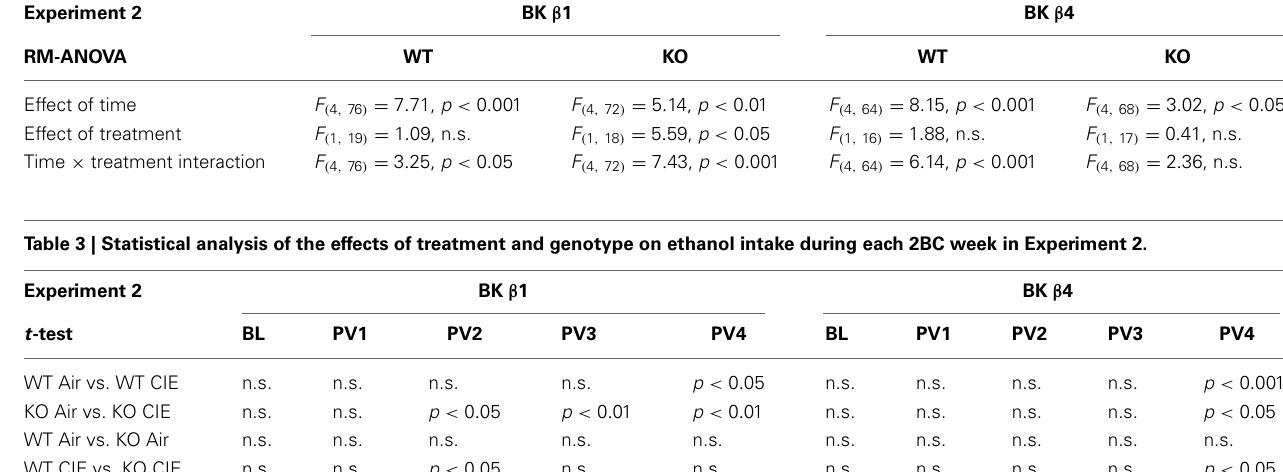
Table 2 | Statistical analysis of the effects of time and treatment on ethanol intake in each genotype in Experiment 2. Experiment 2